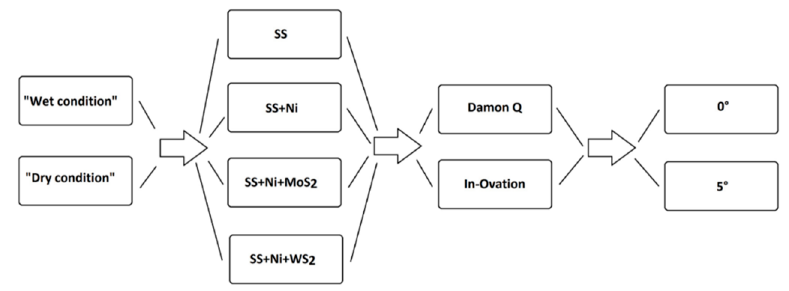
Figure 1. Flow chart of the test condition.